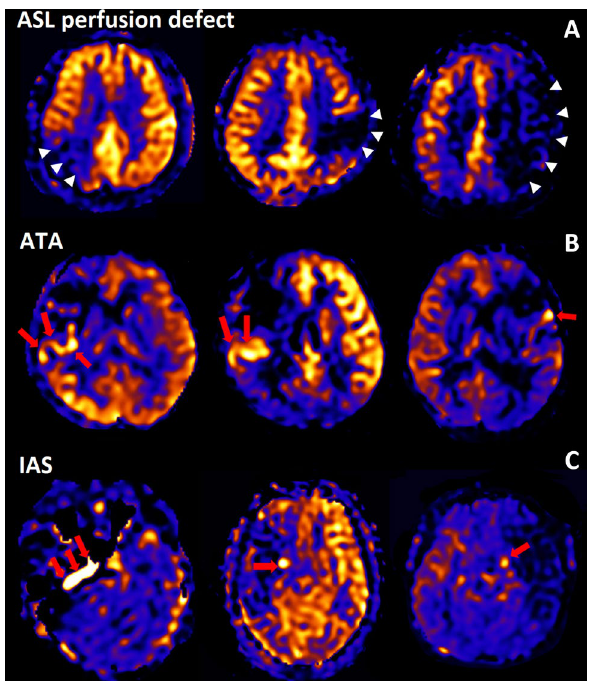
Figure 2. Representative cases of arterial spin labeling (ASL) perfusion deficit, arterial transit artifact (ATA), and intraarterial high-intensity signal (IAS) on multiphase ASL images. (A) ASL perfusion deficit, (B) arterial transit artifact, (C) intraarterial high-intensity